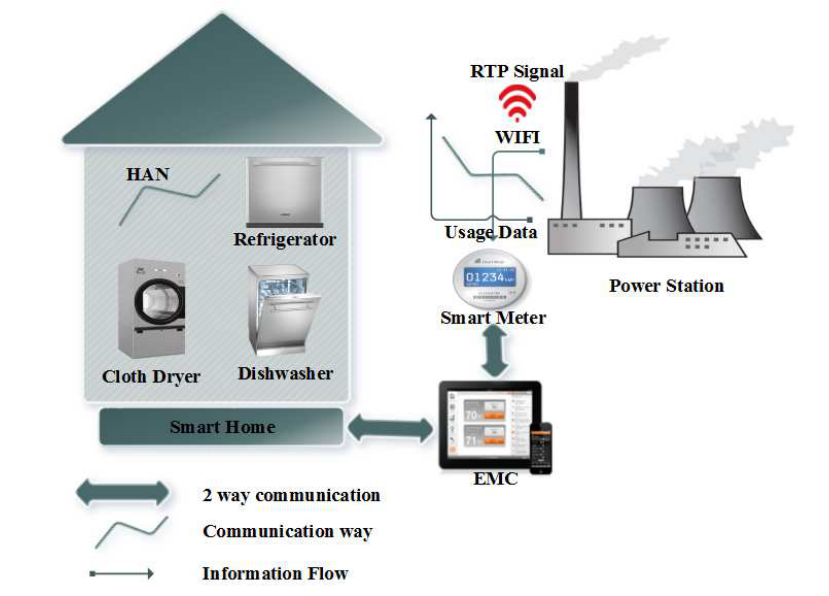
Figure 2. Proposed System